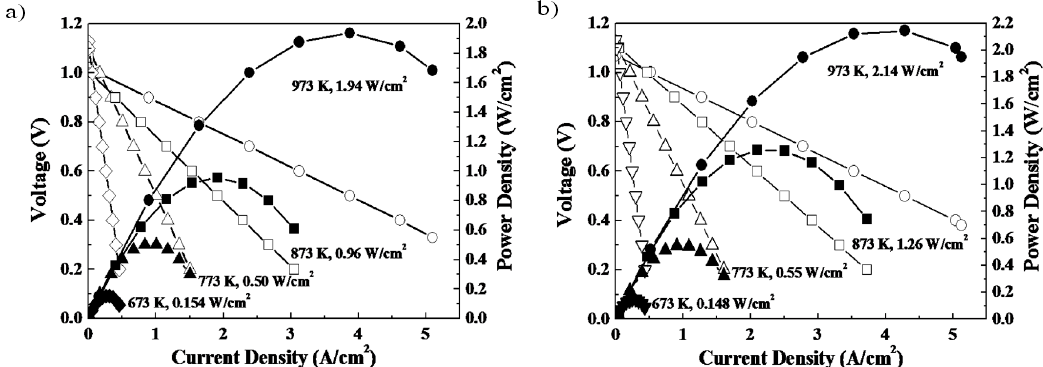
Figure 4. I-V and I-P curves of the cell using ( a ) Sm 0.5 Sr 0.5 CoO 3 porous electrode fabricated from powder; ( b ) added Sm 0.5 Sr 0.5 CoO 3 /Ce 0.8 Sm 0.2 O 2 double columnar interlayer between the electrode and